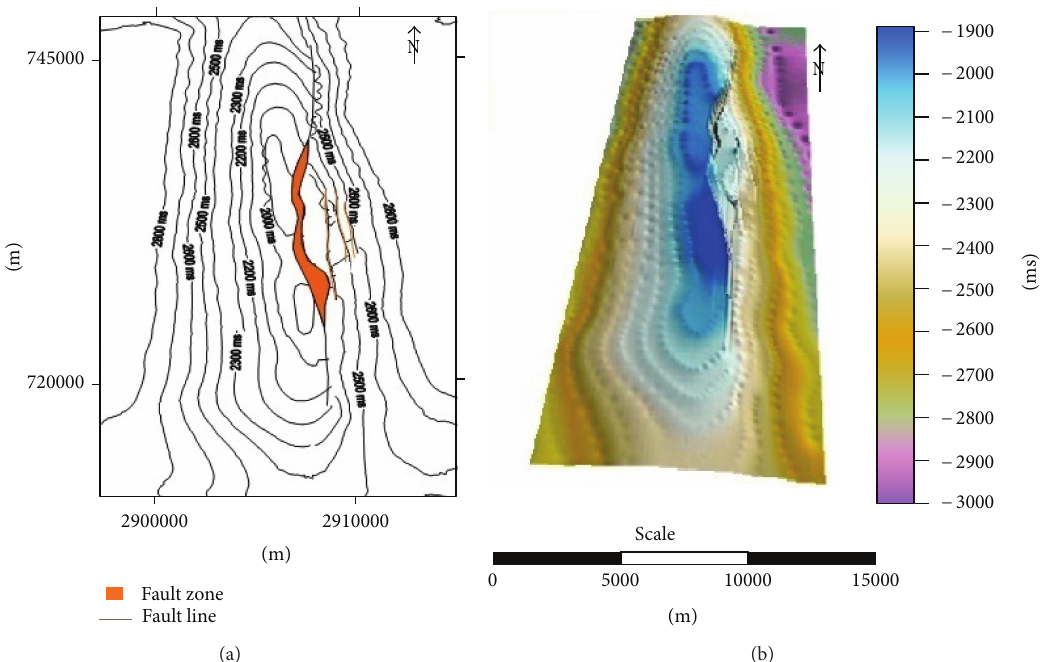
Figure 8: (a) Time structure map on the top of the Lower Gas Sand (R5), Contour interval 100m. (b) Subsurface relief map on the top of the Lower Gas Sand (R5).